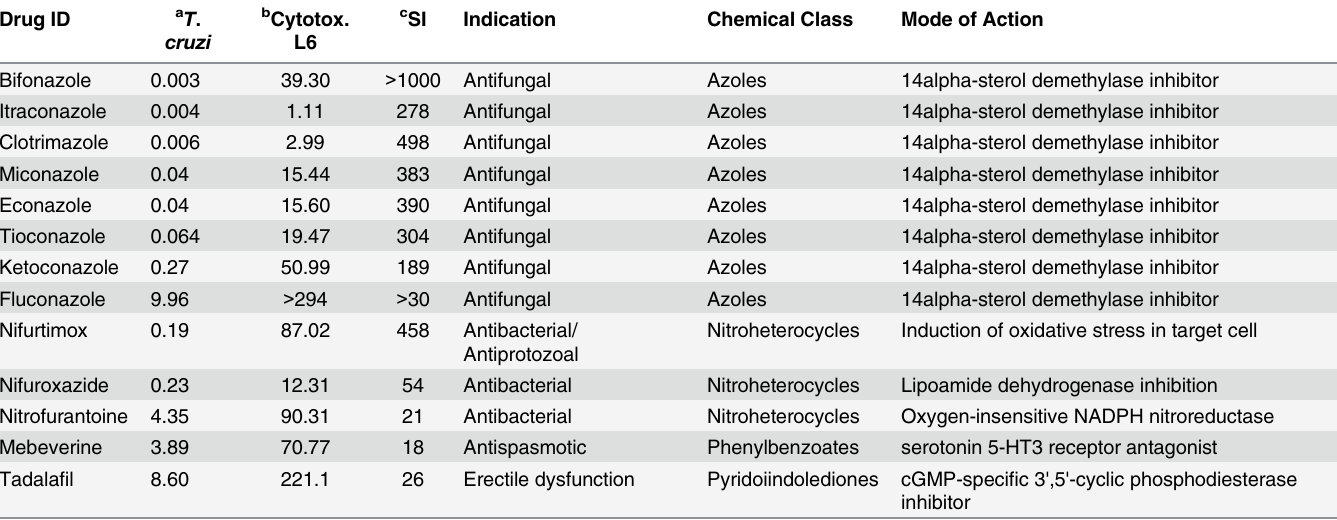
Table 2. In vitro activity against T . cruzi in IC 50 ( μ M) of compounds fulfilling hit criteria. Drug